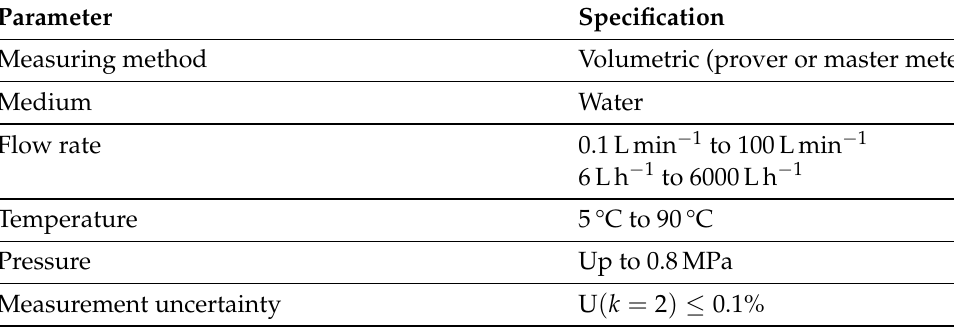
Table 10. Specifications of the water flow calibration facility at RISE